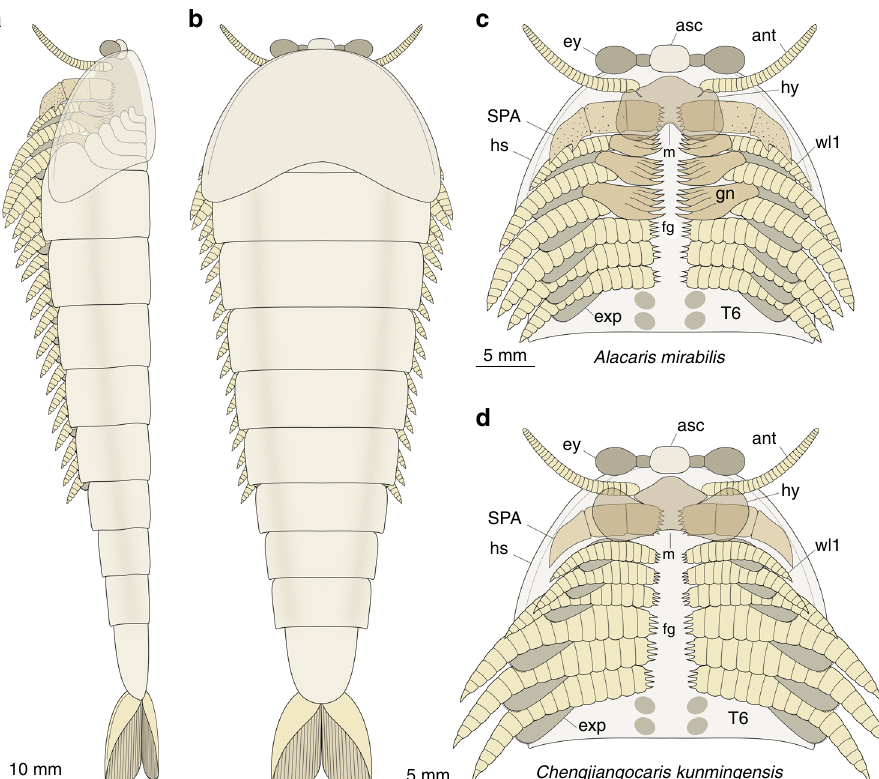
Fig. 4 Morphological reconstruction of Alacaris mirabilis and Chengjiangocaris kunmingensis . a Full-body reconstruction of A. mirabilis in lateral view. b Full- body reconstruction of A. mirabilis in dorsal view. c Ventral view of the head and anterior trunk region of A. mirabilis showing gnathobasic protopodite ventral food groove. d Ventral view of the head and anterior trunk region of C. kunmingensis ; note the differences in the morphology of the hypostome relative to A. mirabilis , and the presence of smaller gnathobasic endites on the proximal limbs. Abbreviations as in Fig.